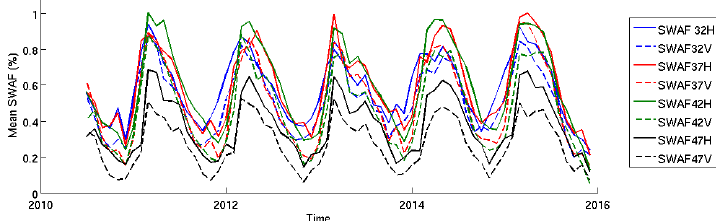
Figure 6. Spatial average of the SWAF over the full Amazon Basin in H polarization (lines) and V polarization (dashed lines) for the four incidence angles: 32 ◦ ± 5 ◦ (blue), 37 ◦ ± 5 ◦ (red), 42 ◦ ± 5 ◦ (green) and 47 ◦ ± 5 ◦